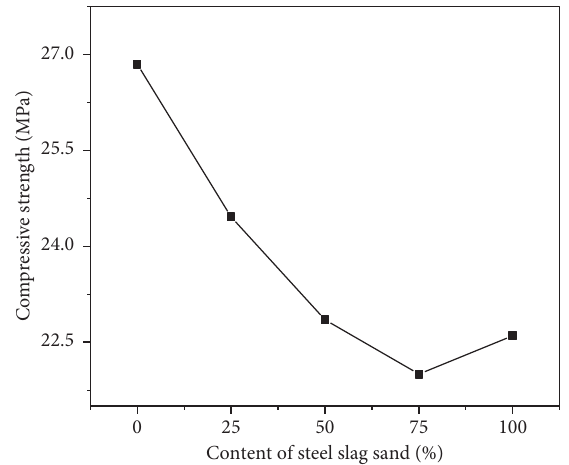
Figure 9: The impact of the content of steel slag sand on the compressive strength of the